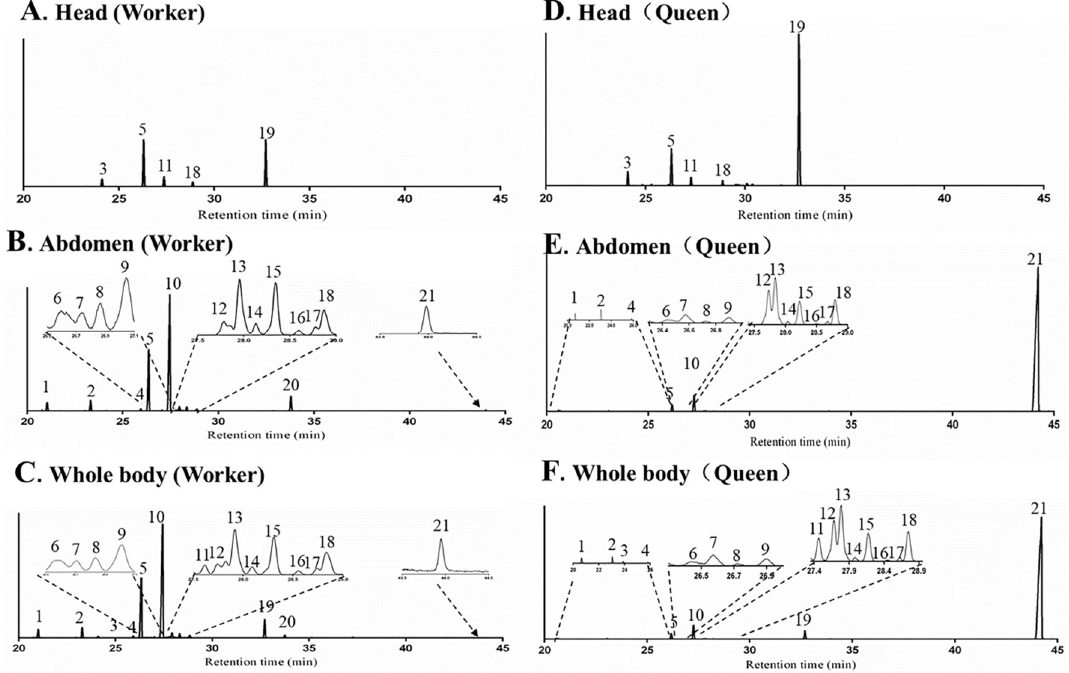
Figure 2. Total ion chromatograms (TICs) of volatile terpenes and terpenoids from the head ( A ), abdomen ( B ) and whole body ( C ) extracts in workers, head ( D ), abdomen ( E ) and whole body ( F ) extracts in queens of Monomorium chinense using SPME-GC-MS analysis with a DB-5 capillary column.